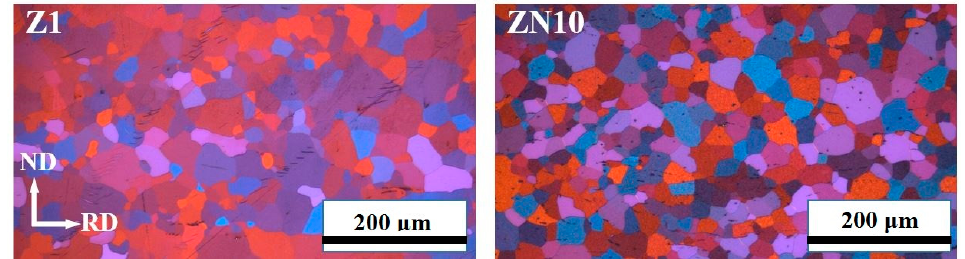
Figure 2. Optical micrographs of the annealed Z1 and ZN10.